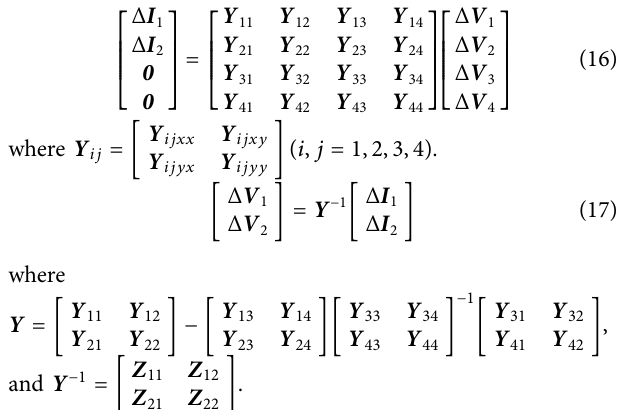
FIGURE 6 | Schematic of the PV power generation